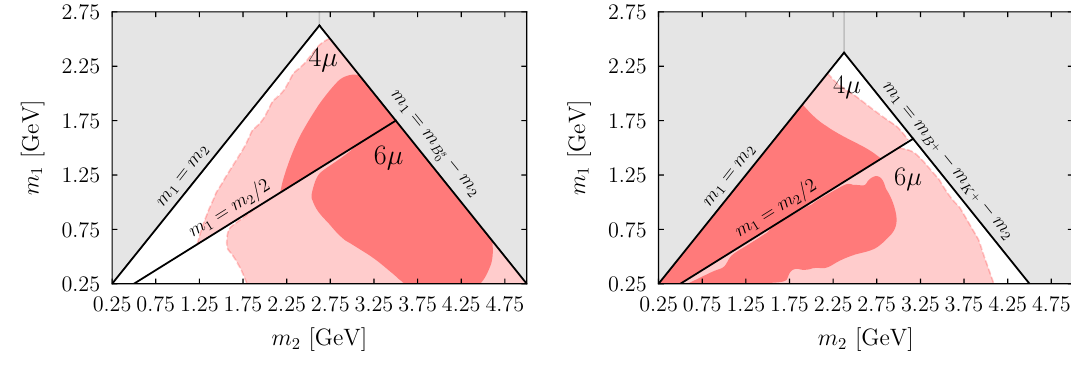
Figure 5 . (Left) Light scalar masses that could be probed with the analysis proposed in this work in the channels B 0 → 2 µ + 2 µ − ( m 2 < 2 m 1 region) and B 0 → 3 µ + 3 µ − ( m 2 > 2 m 1 region). The s s dark and light red lines enclose the parameter space that could be probed, respectively, at Run 3 and Run 5 of LHCb. The lighest particle lifetime is fixed to τ 1 = 100 ps, g 12 = 1 . 5 and the chosen resonance parameters are signaled by a star in figure 7. Only the upper limits derived in section 3 from downstream tracks were considered. (Right) The same analysis applied to B + → K + 2 µ + 2 µ − and B + → K + 3 µ + 3 µ − .